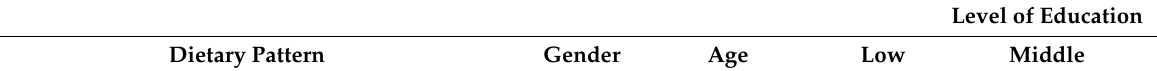
Level of Education